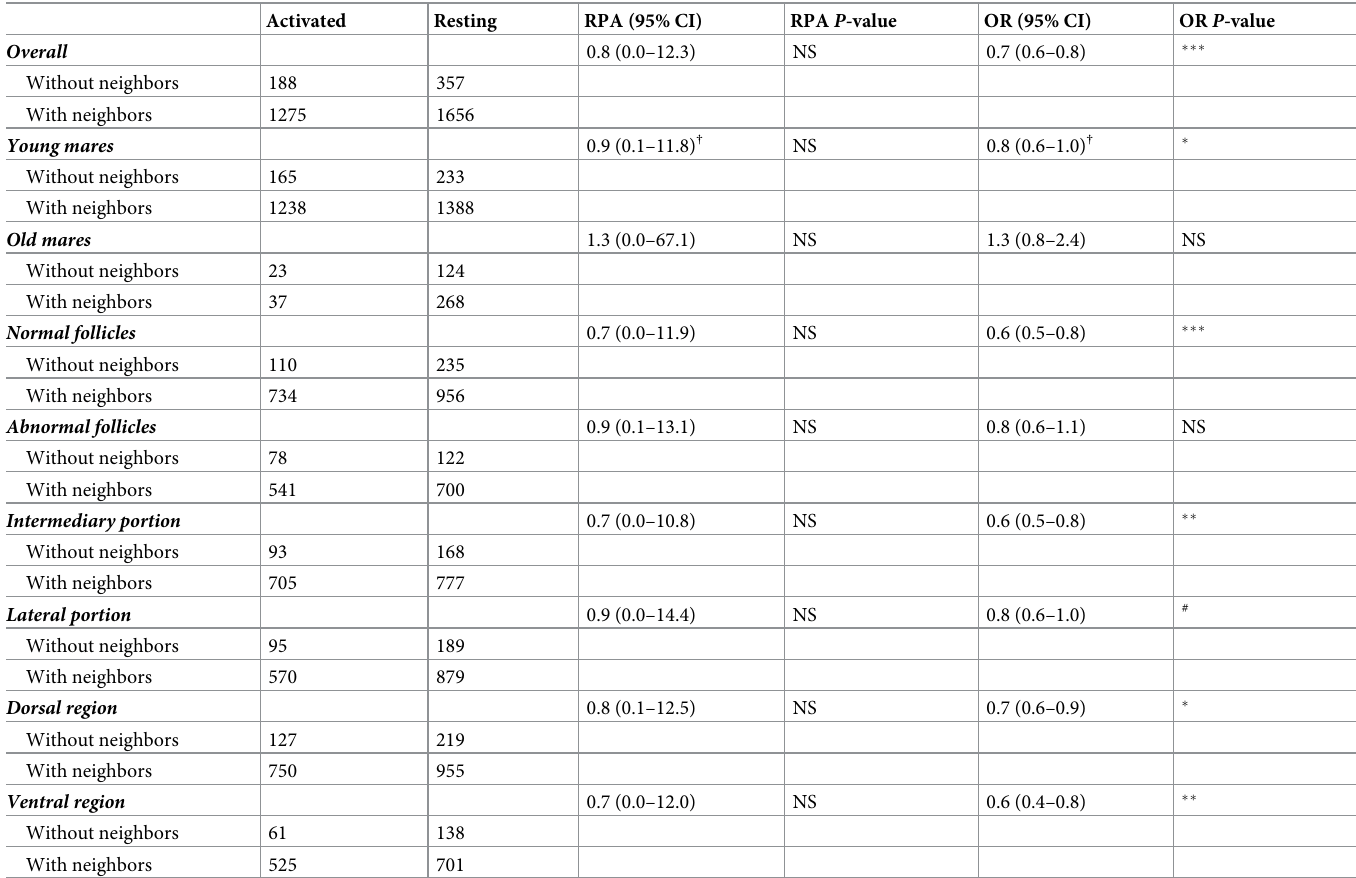
Table 3. Association analyses between developmental stages and presence of follicle